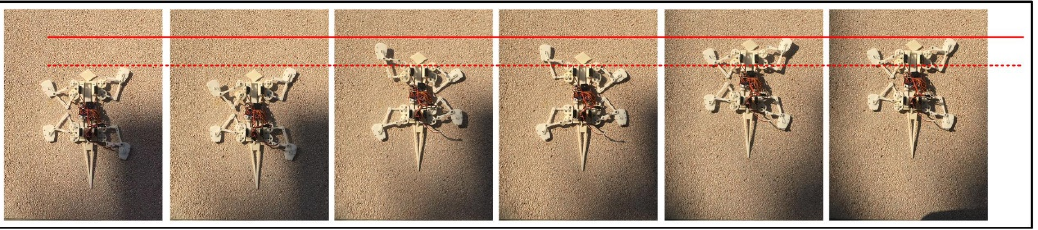
Figure 12. Experiment of the locomotion of the bionic robot climbing on the stone surface in cycle.